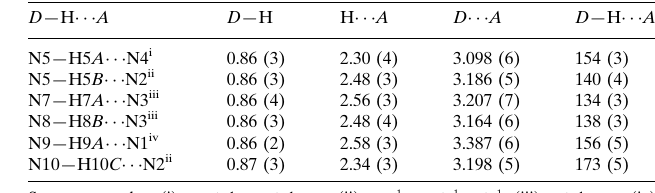
Hydrogen-bond geometry (A˚ , (cid:3)